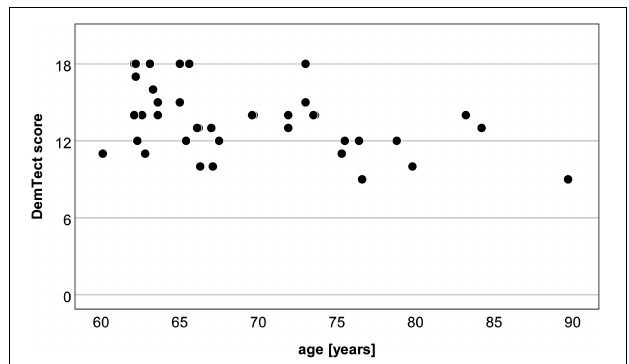
FIGURE 2 | Scatter plot of age and DemTect scores of the 40 test subjects. Thirteen–eighteen points: age-appropriate cognitive performance; 9–12 points: slight impairment; ≤ 8 points: suspicion for dementia.